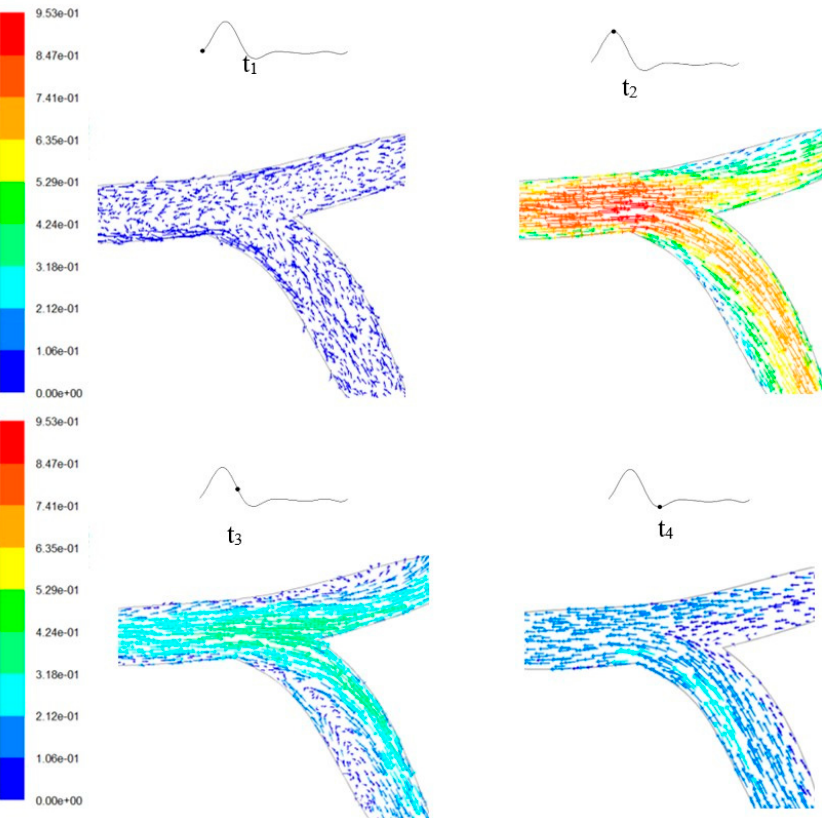
Figure 12. Vector distribution of velocity magnitude (m/s) for the median x-y plane at different instants of acceleration and deceleration phase of the cardiac cycle.